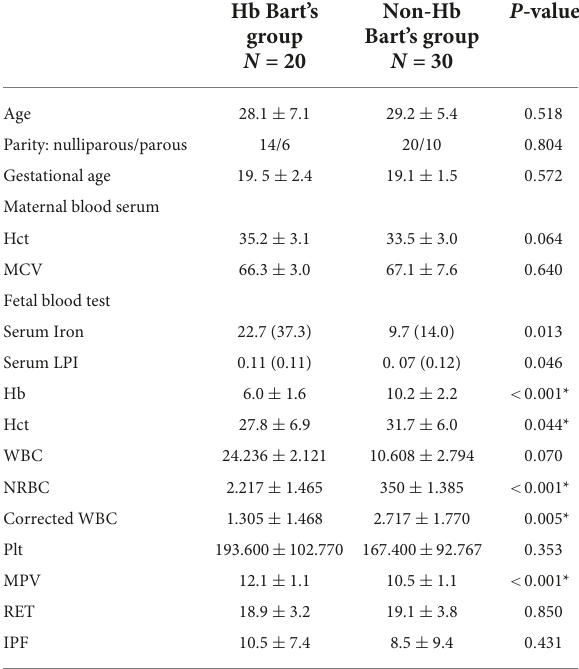
TABLE 1 Baseline characteristics of both